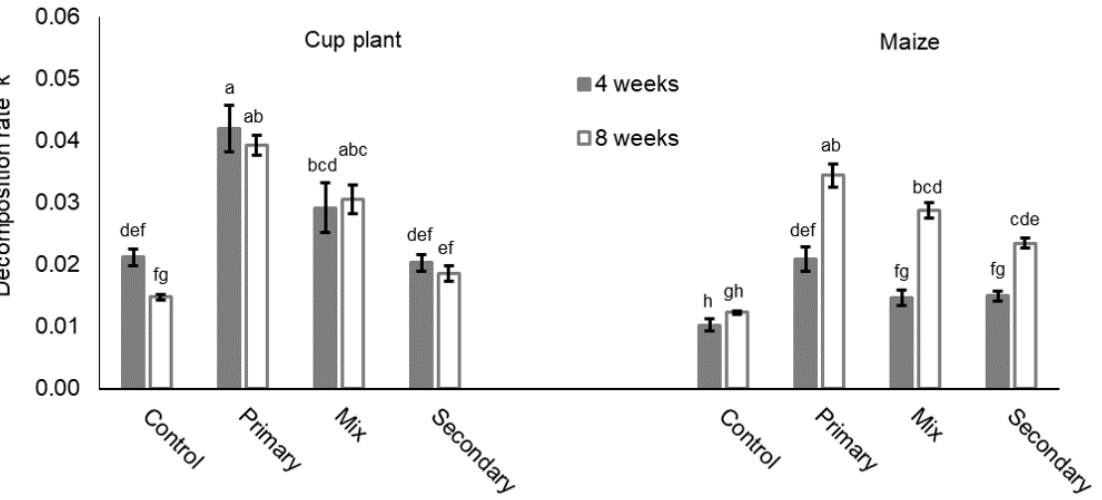
Figure 1. Decomposition rate k (means ± SE, n = 5) for cup plant and maize treatments after 4 and 8 weeks of incubation. Control = without earthworms; primary = primary decomposer L. terrestris ; secondary = secondary decomposers A. caliginosa and A. rosea; mix = primary and secondary decomposers. For statistics see Table 3 and Supplementary Information Table S6; for further information see Supplementary Information, Tables S1 and S2.